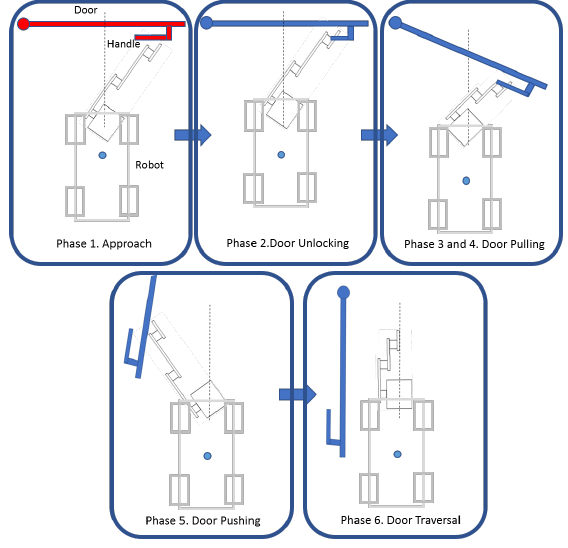
Figure 10. Substeps for opening closed